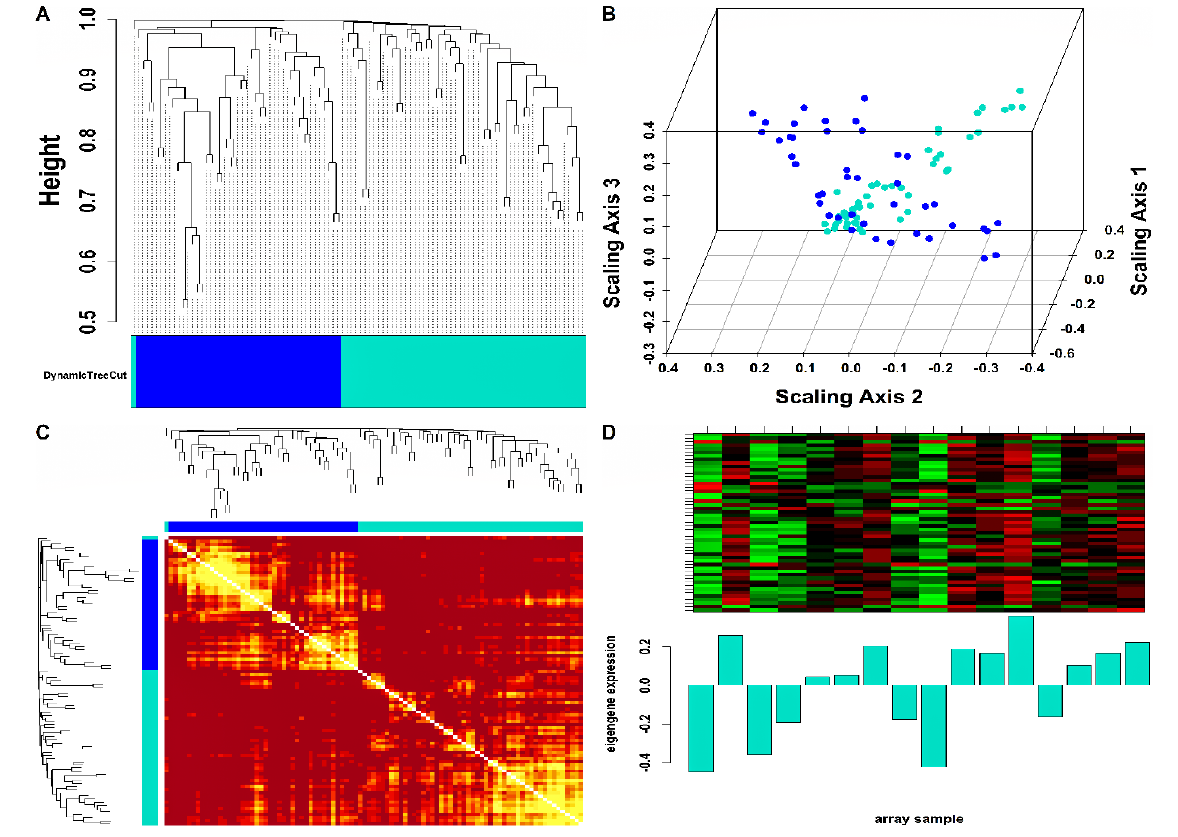
Figure 3. ( A ) Hierarchical clustering dendrogram of 93 Mo-DEGs clustered based on dissTOM and two color-coded modules obtained using Dynamic Tree Cut. The sizes of the module were as follows: blue (42) and turquoise (51). ( B ) 3D MDS plot where each colored point denotes a gene belonging to the module of its equivalent color in the case of the Mo group. ( C ) Representation of WGCN as a TOM plot for Mo-DEGs. Genes within columns and their corresponding rows were hierarchically clustered by cluster dendrograms (displayed along the top and left side of the plot). Progressively darker and lighter red colors within the matrix indicate higher and lower topological overlap among genes. Dark-colored blocks along the diagonal signify the modules. ( D ) Expression heatmap of turquoise module genes where the rows and columns correspond to genes and samples. The red and green color bands within the heatmap imply higher and lower expression levels across turquoise module genes. In addition, the corresponding ME expression levels (along the y -axis) across all samples (along the x -axis) are displayed at the bottom panel of the module heatmap in the form of a barplot.